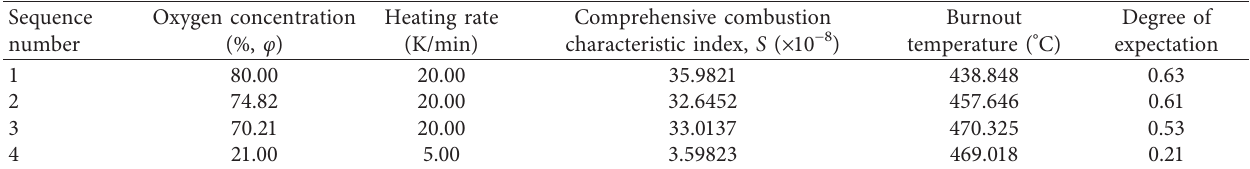
Table 8: Comprehensive optimization scheme of various indexes of coal under different oxygen concentration and heating rate.